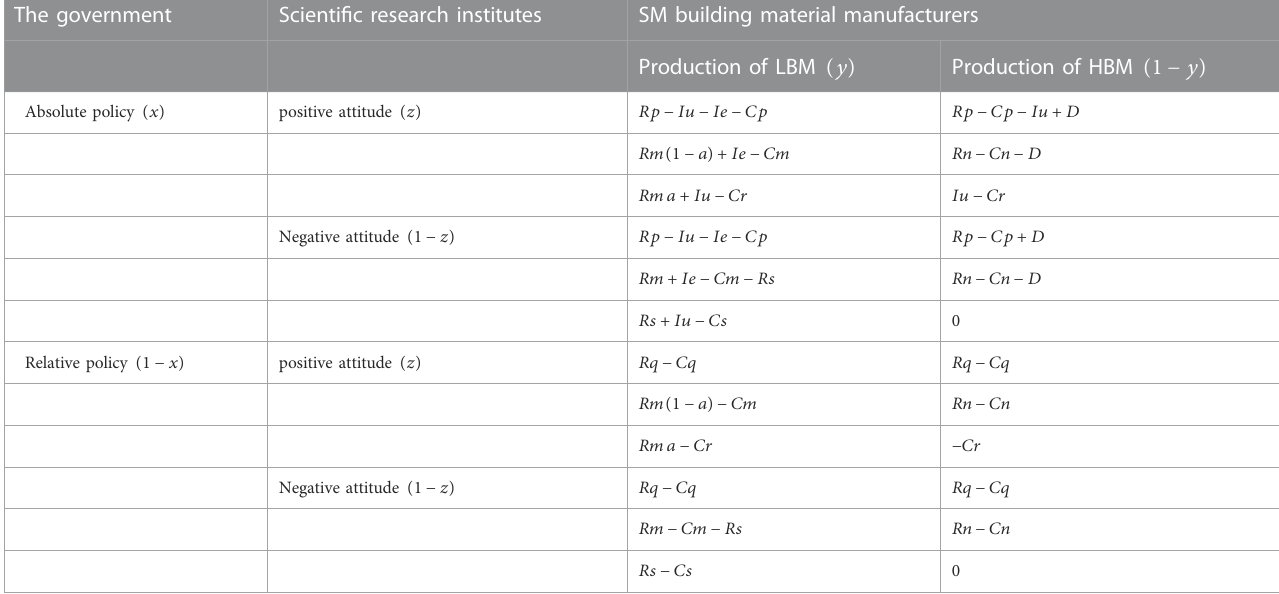
TABLE 2 Payoff matrix of the three-party game mode. The